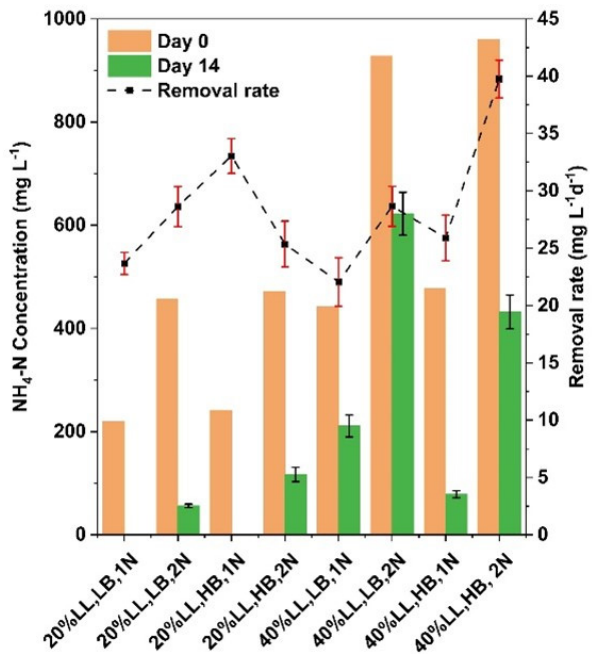
Figure 2. The initial and final concentration of NH 4 -N and removal rate by G. sulphuraria cultured in different LL media compositions for 14 days. Refer to Table 1 for LL media composition details.